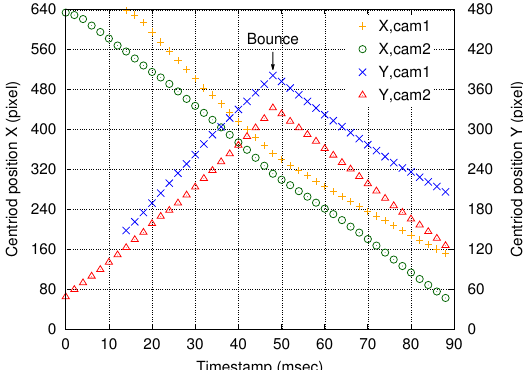
Figure 6. Time-series plot of calculated centroid positions X and Y , which represent the positions of the moving ball in the 640 × 512-pixel images acquired by cameras 1 and 2 at 500 fps. The timestamp at the first ball detection by camera 2 was used as the time origin, t = 0. The timestamp error between the two nodes for each frame was less than 10 µ s. A ball bounce was observed at t = 48.0 ms in both master and slave images.